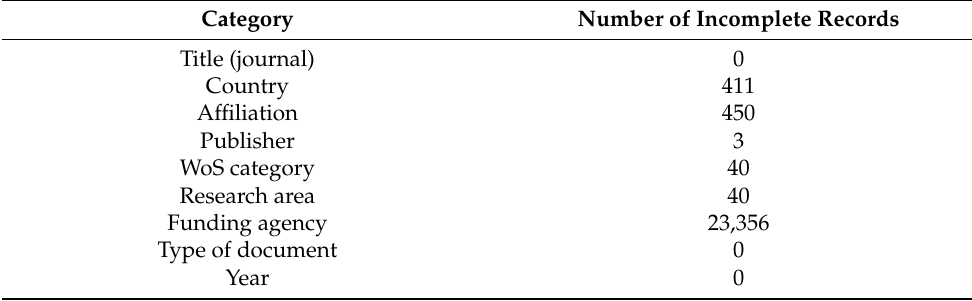
Table 3. Incomplete records in individual categories.